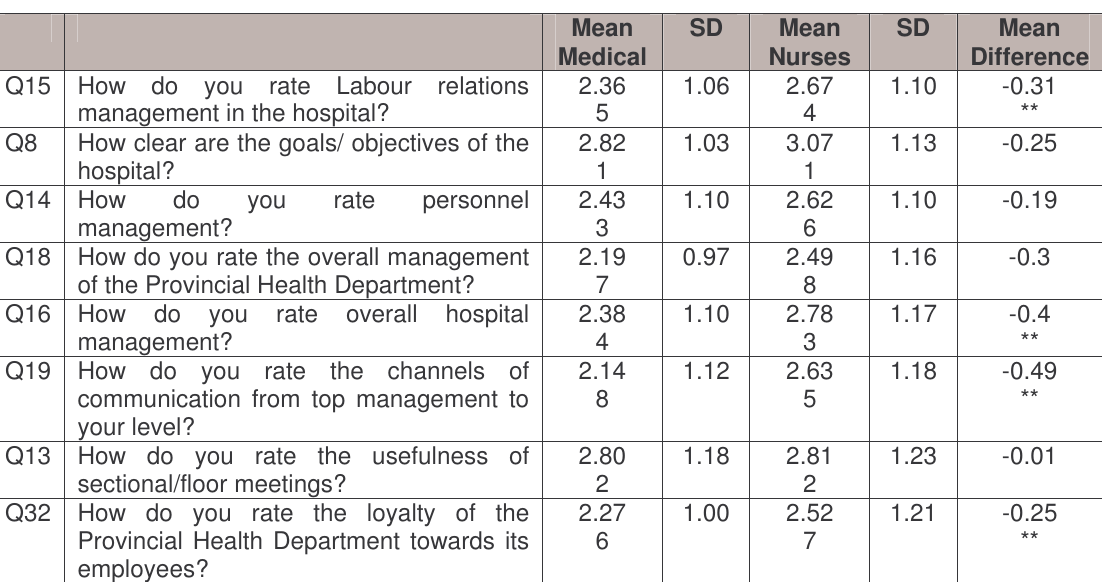
Table 2: Management policies (Average mean 2.54)